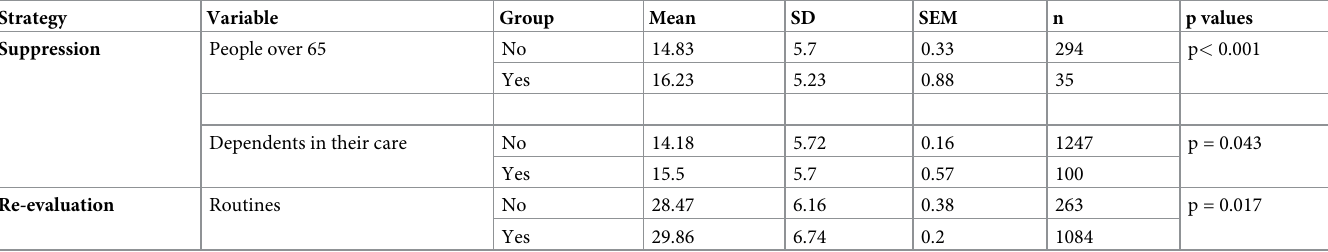
Table 6. Lockdown variables that were significantly related to emotional regulation.